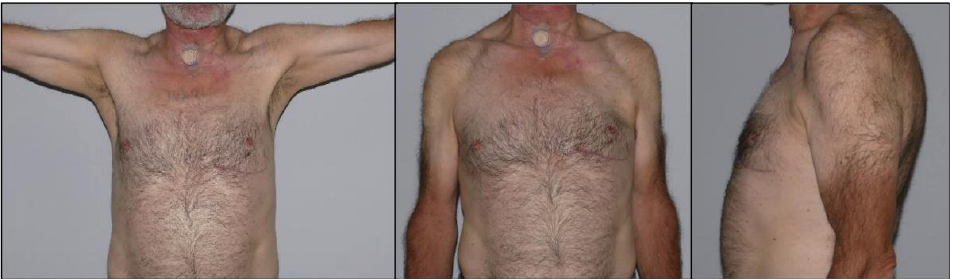
Figure 3. Clinical outcome in a patient after PMMF of the left side 135 days post